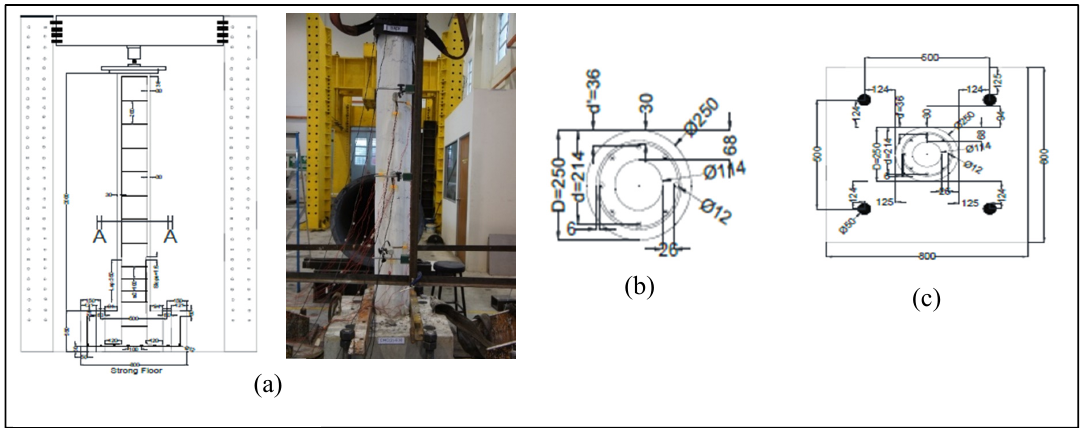
Figure 2. Circular hollow unconfined RC column detail specification; (a) Front view (b) A-A section view (c) Plan view [2].